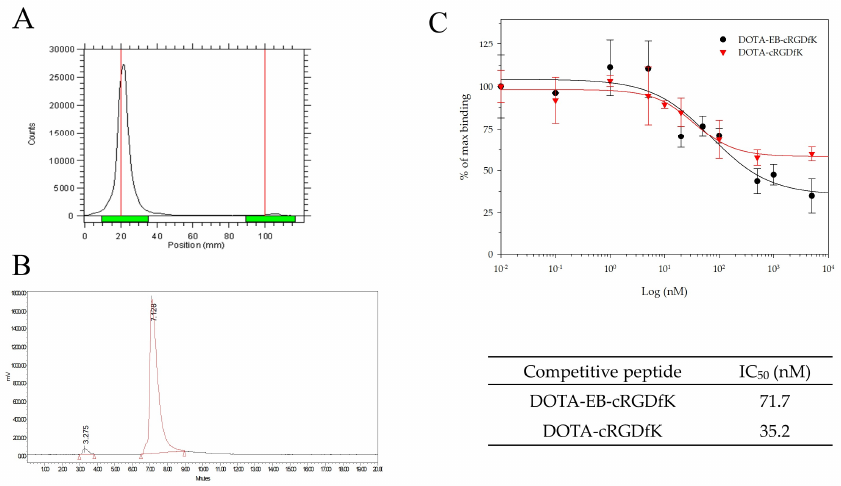
Figure 2. In vitro characterization of 111 In-DOTA-EB-cRGDfK. ( A ) The labeling efficiency was 98% by radio-TLC analysis. ( B ) The radio HPLC analysis revealed that the radiochemical purity was 96% with a retention time of 7.2 min. ( C ) U-87 MG cells were used for cell-binding assays and competed with DOTA-EB-cRGDfK or DOTA-cRGDfK. The IC 50 values of DOTA-EB-cRGDfK and DOTA-cRGDfK were 71.7 nM and 35.2 nM,